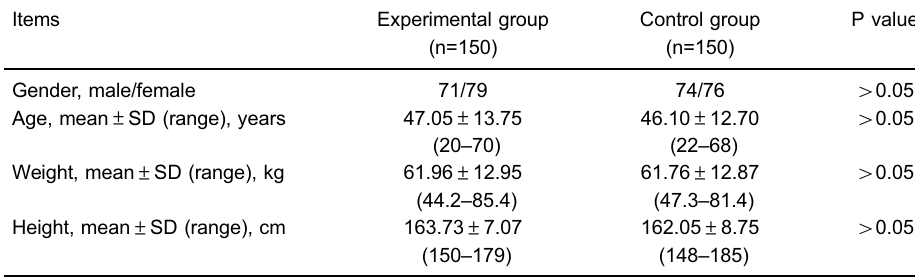
Table 1. Demographic data for the two